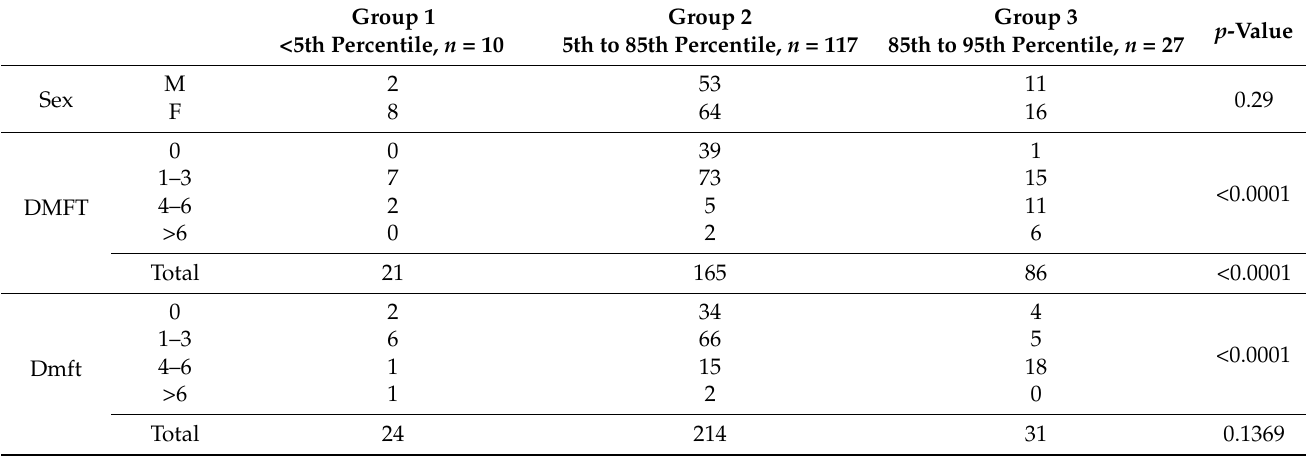
Table 2. Index for permanent teeth (DMFT) score, index for deciduous teeth (dmft) score in underweight, normal, and overweight patients.